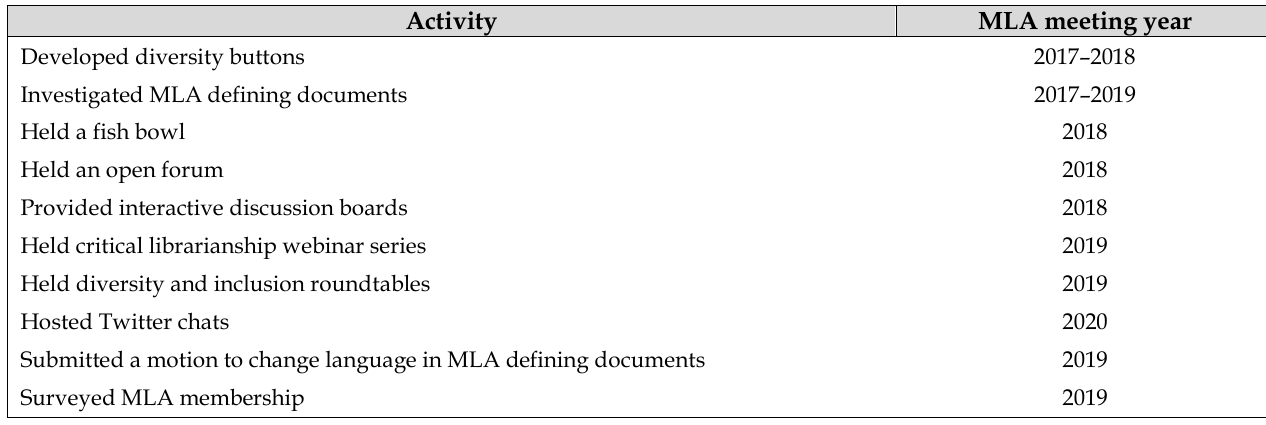
Table 3 Summary of task force activities